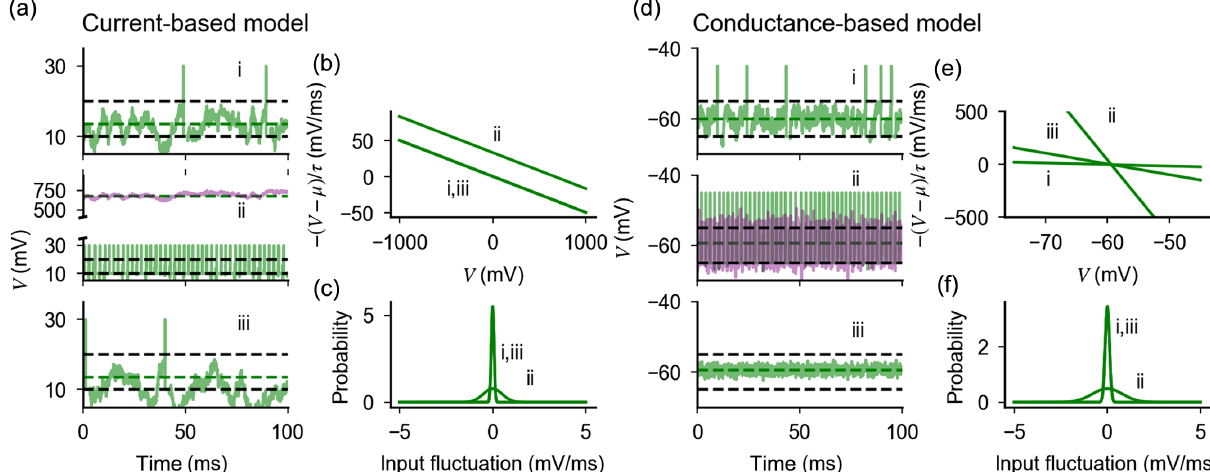
FIG. 1. Effects of coupling strength on the firing behavior of current-based and conductance-based neurons. (a) Membrane potential of a single current-based neuron for (i) J ¼ 0 . 3 mV, K ¼ 10 3 , g ¼ γ ¼ 1 , and η such that 1 − g γη ¼ 0 . 075 ; (ii) with K ¼ 5 × 10 4 ; ffiffiffiffi p K , which gives J ¼ 0 . 04 mV) and input difference 1 − g γη ¼ 0 . 01 ; (b),(c) (iii) with K ¼ 5 × 10 4 and scaled synaptic efficacy ( J ∼ 1 = Effect of coupling strength on drift force and input noise in a current-based neuron. (d) Membrane potential of a single conductance- based neuron for fixed input difference ( g 1 − γη ¼ − 2 . 8 ) and (i) a ¼ 0 . 01 , K ¼ 10 3 ; (ii) K ¼ 5 × 10 4 ; (iii) K ¼ 5 × 10 4 and scaled ffiffiffiffi p K synaptic efficacy ( a ∼ 1 = , a ¼ 0 . 001 ). (e),(f) Effect of coupling strength on drift force and input noise in a conductance-based neuron. In (a) and (d), dashed lines represent the threshold and reset (black) and equilibrium value of membrane potential (green). In (a) (ii) and (d)(ii), light purple traces represent dynamics in the absence of a spiking mechanism. Input fluctuations in (c) and (f) represent ffiffiffi p τ ζ of Eq. (4) computed over an interval Δ t and normalized over Δ t input noise per unit time, i.e., the integral of σ